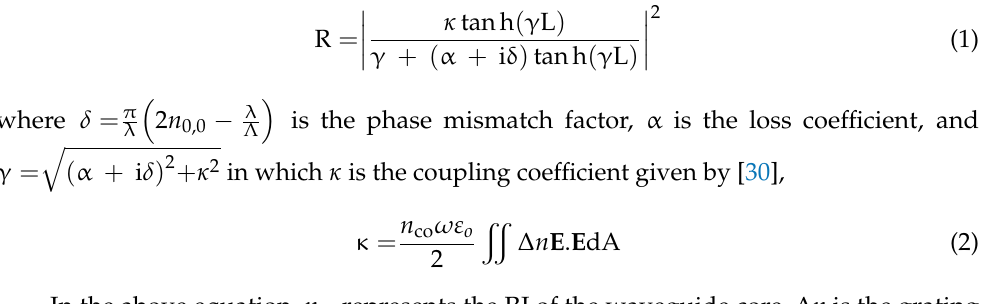
Figure 2. Major field component ( a ) E x of TE 00 mode and ( b ) E y of TM 00 mode. The waveguide parameters are w = 1.2 μ m, h = 1.2 μ m, t m = 200 nm, and t H = 30 nm.